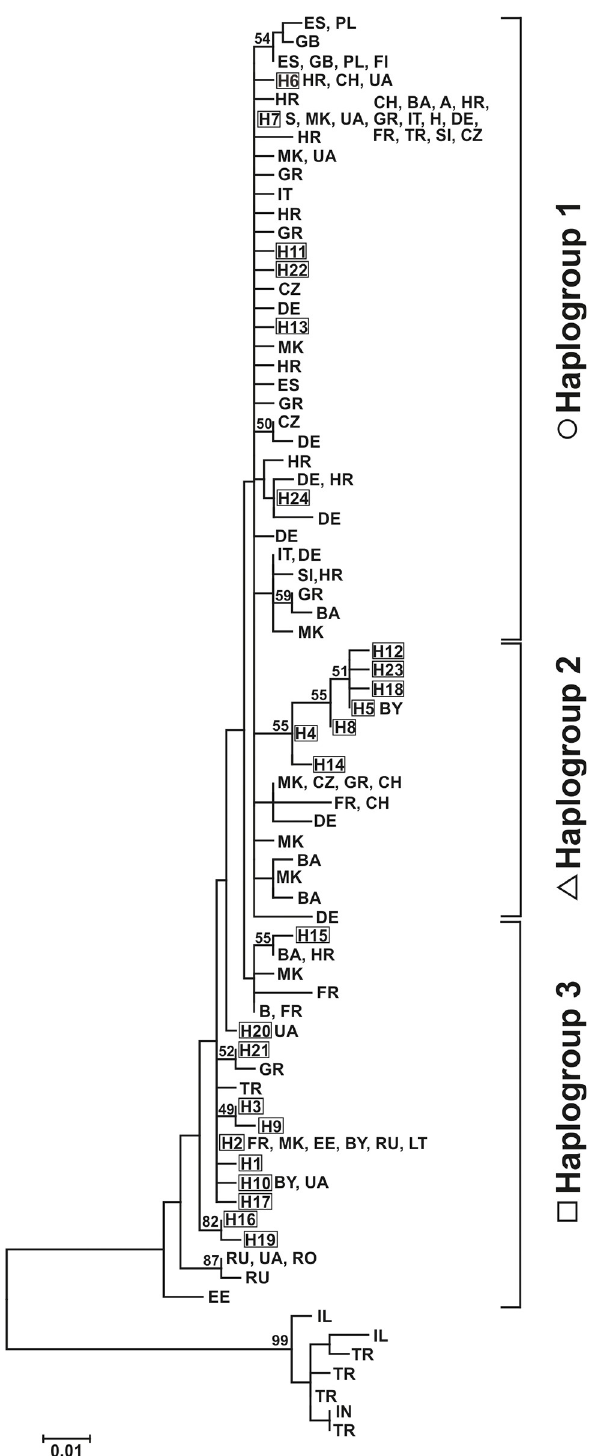
Fig 3. Maximum likelihood tree of cyt b fragment of mtDNA haplotypes of yellow–necked mouse found in NE Poland (H1 − H24) and recorded in other studies. Bootstrap values shown if greater than 50%. Sequences from GenBank are coded according to the country location. List of data and sources in S2